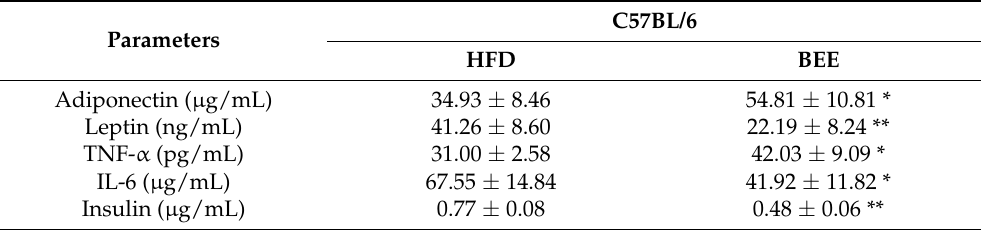
Table 3. Effects of BEE treatment on various obesity-related hormone and cytokine parameters in